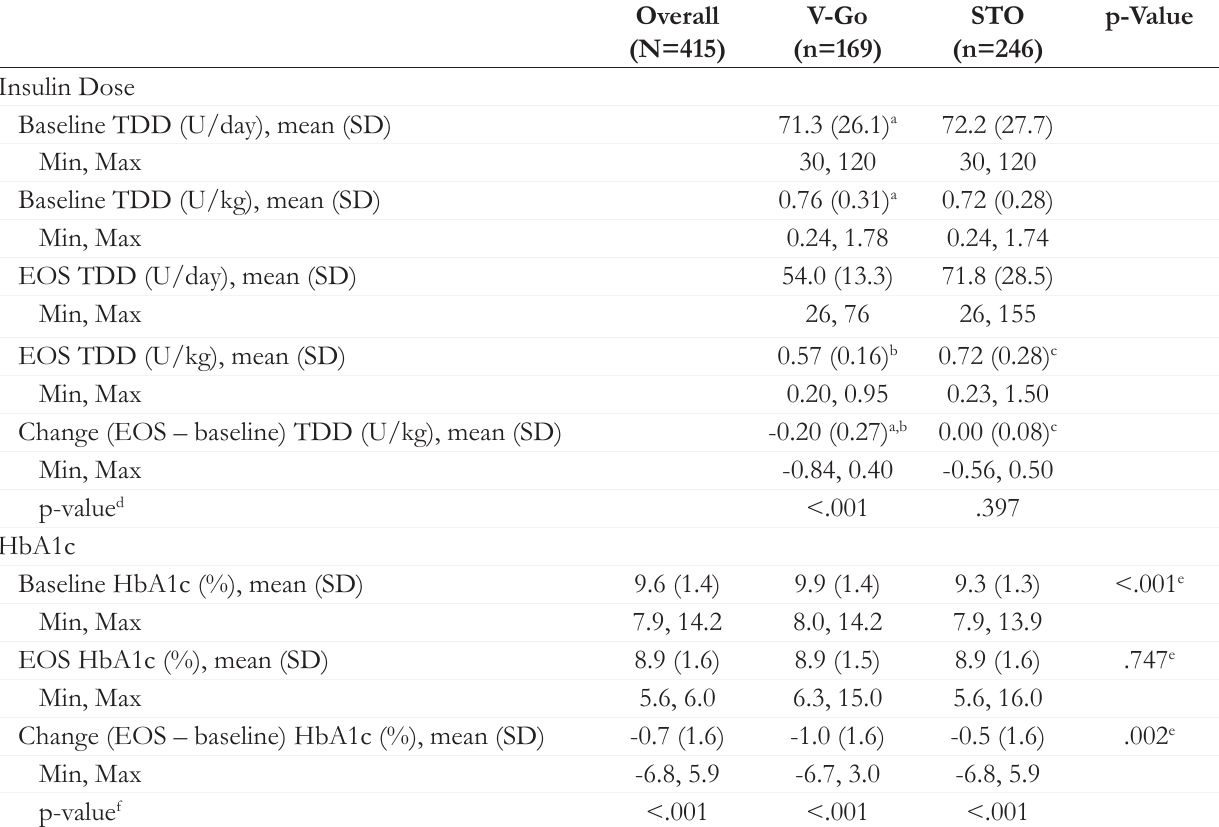
Overall V-Go (N=415)